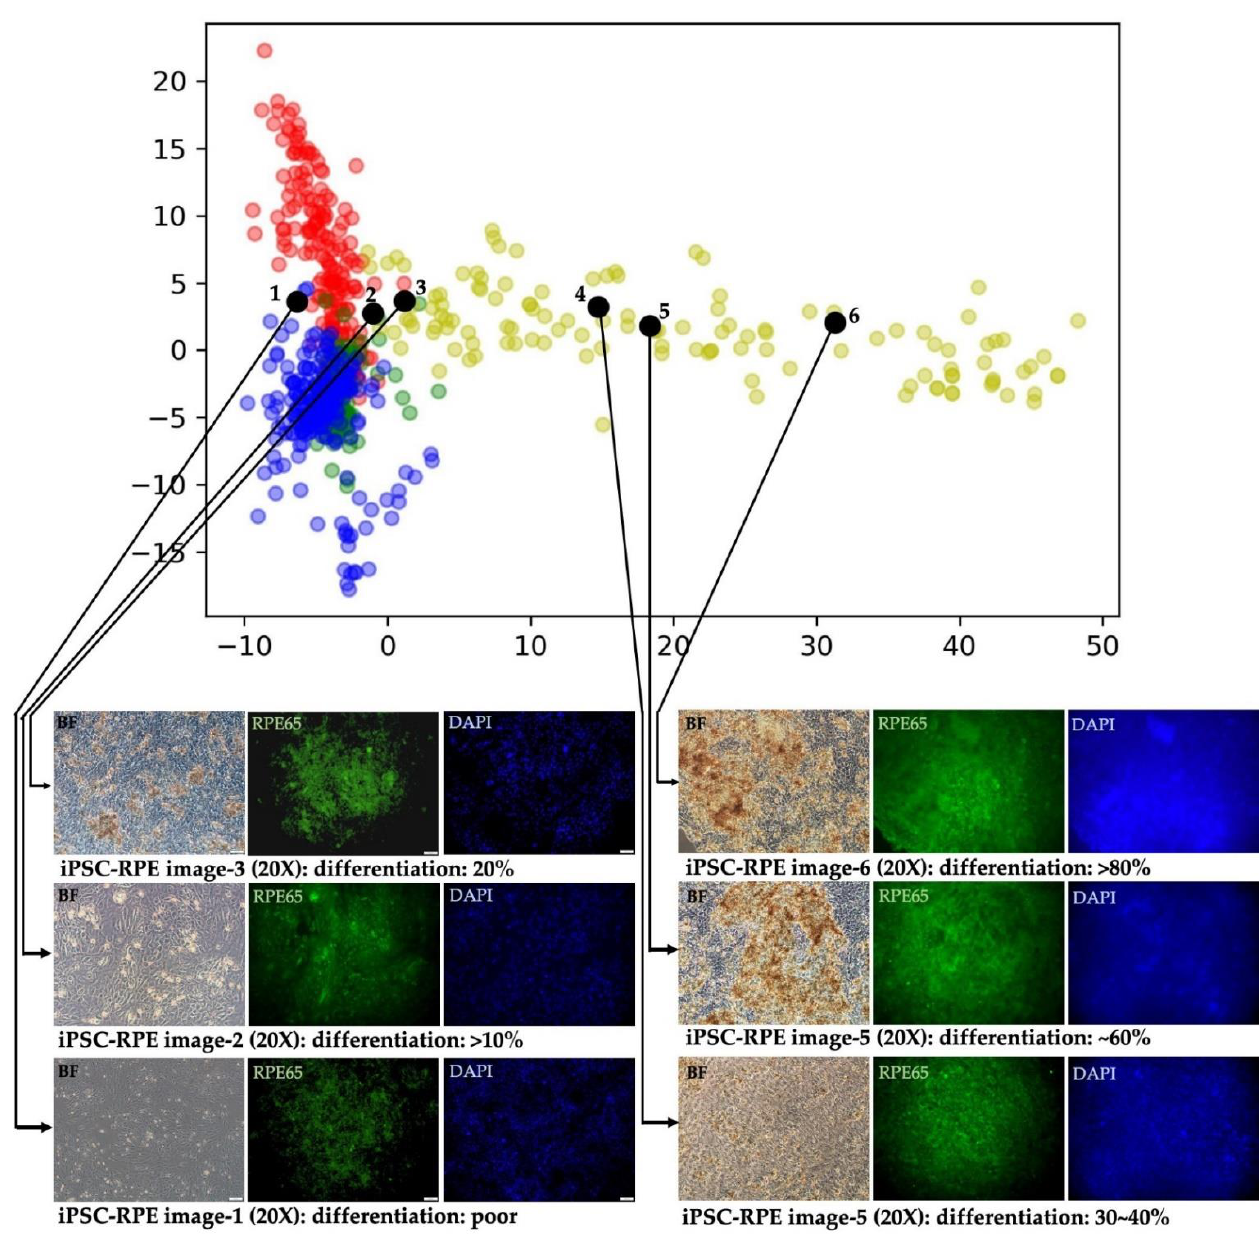
Figure 9. Using iPSC-RPEs with various differentiation degree as the input to verify the accuracy of iPSC-RPE image recognition by the multi-slice tensor model. In the scatter plot of iPSC-RPEs (yellow green spots), iPSC-RPEs with poor differentiation were projected to the left side, iPSC-RPEs with moderate differentiation to the middle, and iPSC-RPEs with high differentiation-to the right side of the scatter plot.